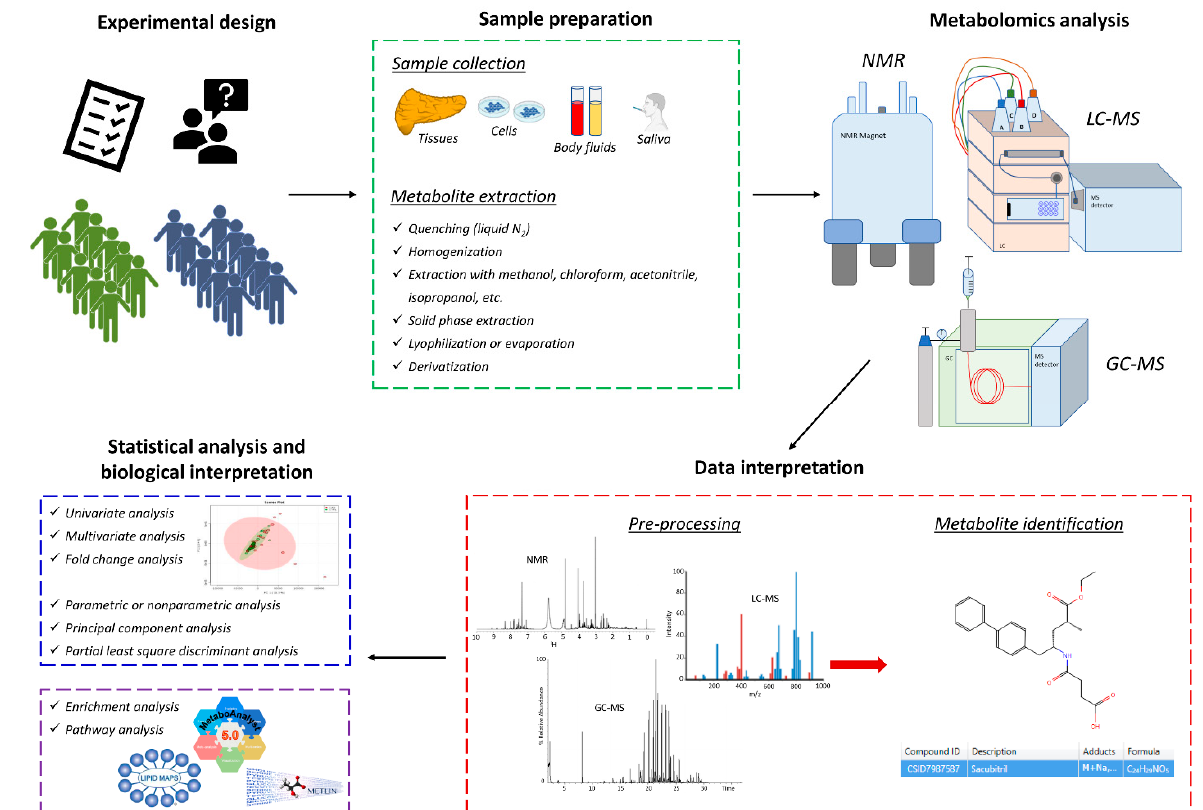
Figure 1. Schematic workflow of metabolomic studies. Several steps are involved from experimental design and biological sample preparation to data analysis, processing, and interpretation. Nuclear magnetic resonance (NMR) spectroscopy and mass spectrometry (MS) are the main analytical technologies used in metabolomics research. GC-MS, gas chromatography-MS; LC-MS, liquid chromatography-MS.